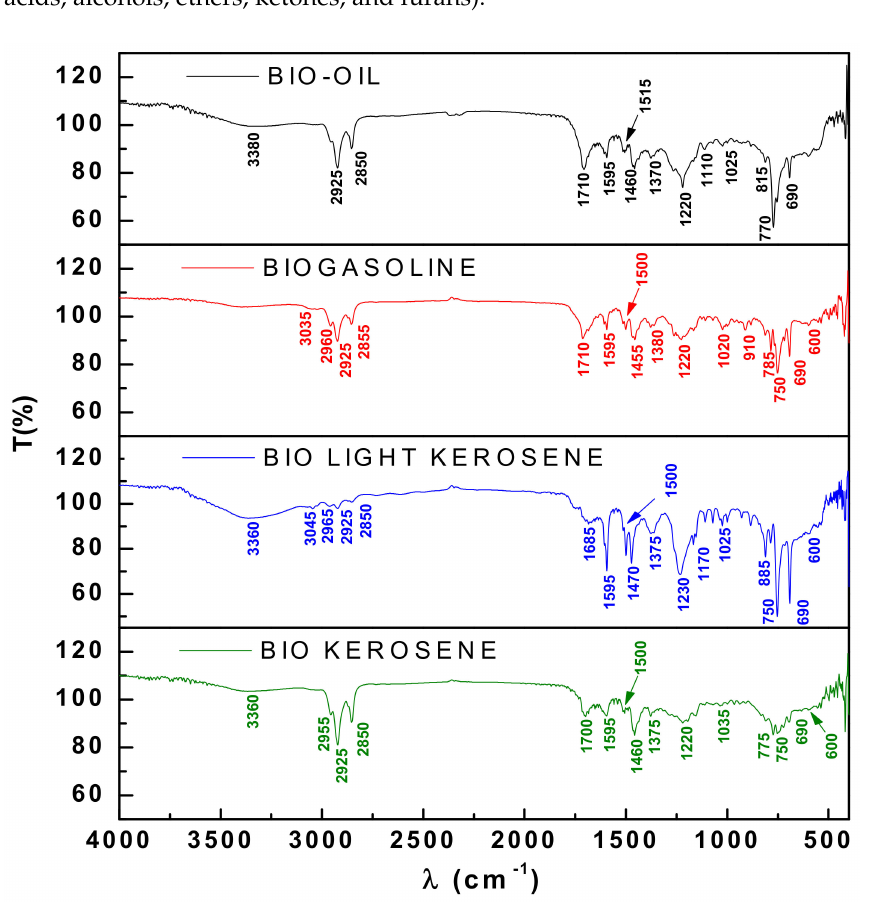
Figure 11. FT-IR of bio-oil obtained by pyrolysis of Aça í seeds pyrolysis at 450 ◦ C and 1.0 atmosphere, in pilot scale, and the distillation fractions (gasoline: 40–175 ◦ C, light kerosene: 175–200 ◦ C, and kerosene-like fraction: 200–215 ◦